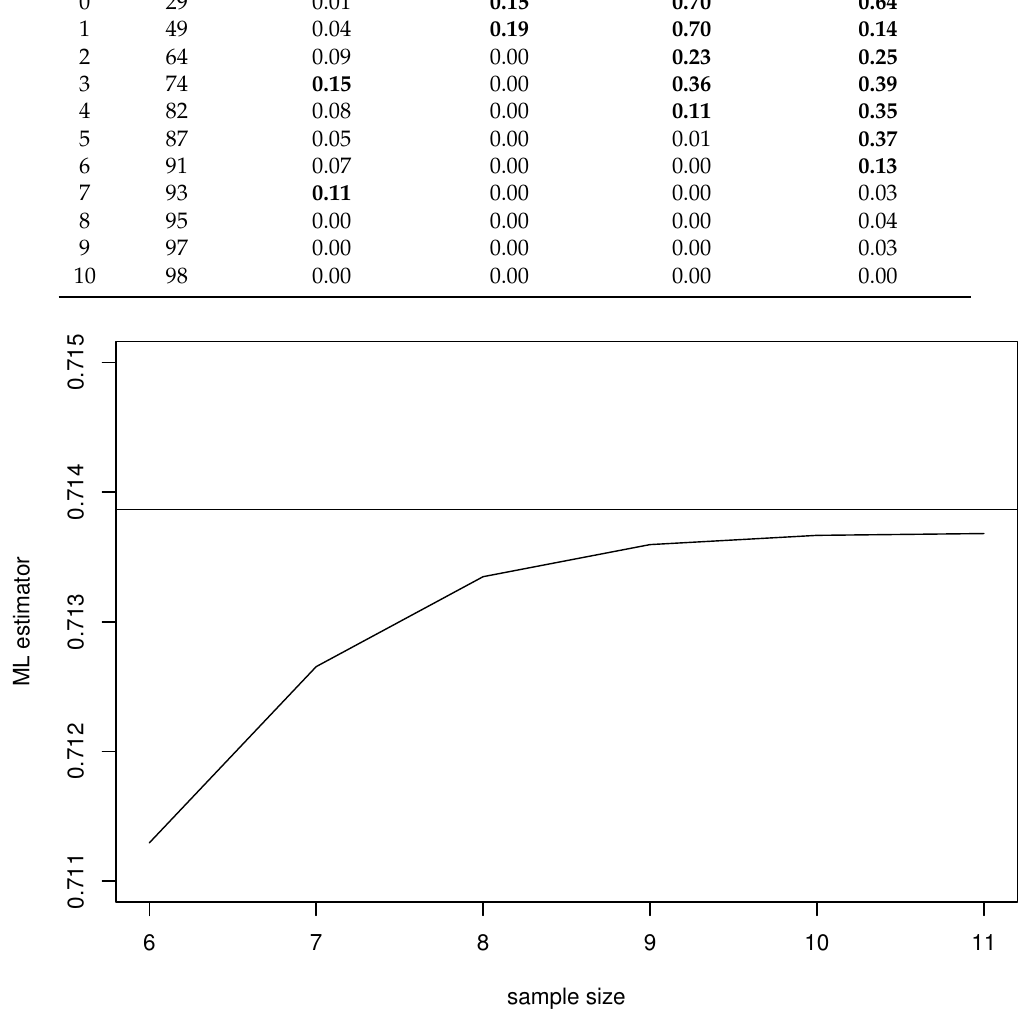
Figure 4. ˆ ρ as a function of the sample size